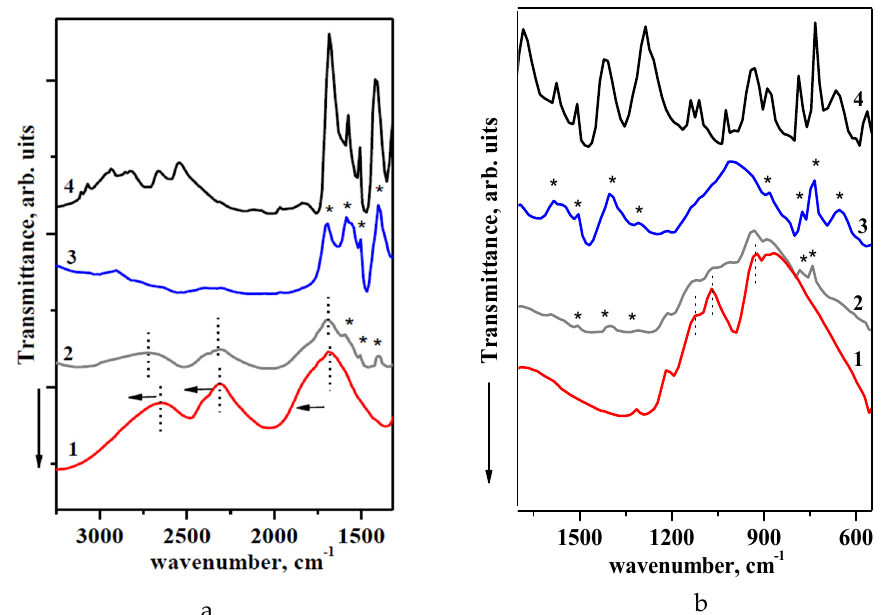
Figure 6. FTIR spectra of (1 − x)CsH 2 PO 4 -xUiO-66 for different compositions: 1—CsH 2 PO 4 ; 2—x = 0.018; 3—0.035; 4—UiO-66.